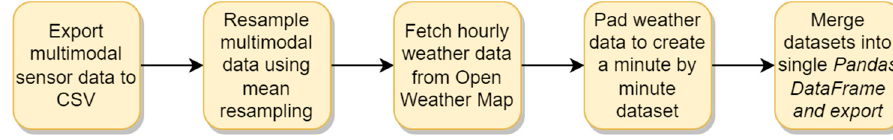
Figure 2. Multi-step process for merging data from multiple